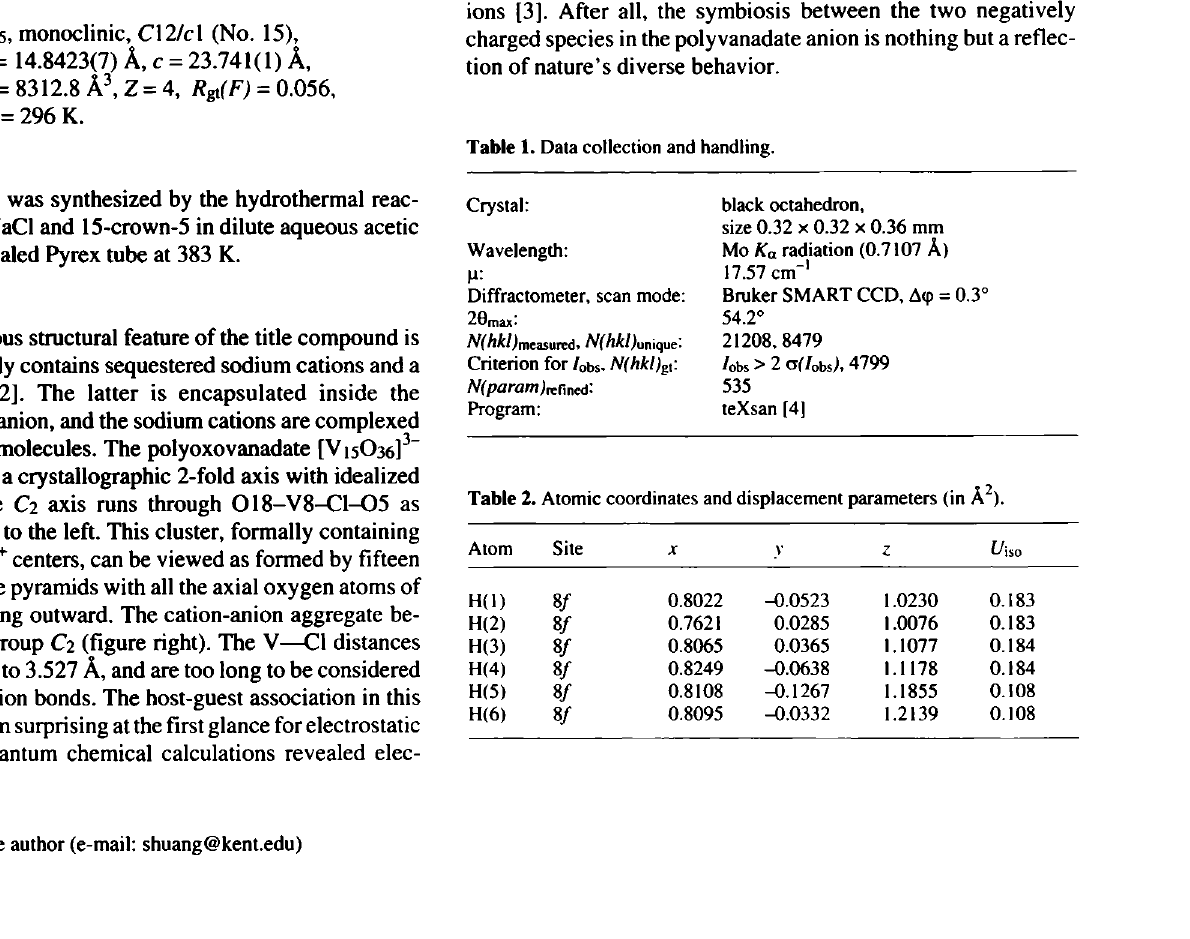
Table 1. Data collection and handling.